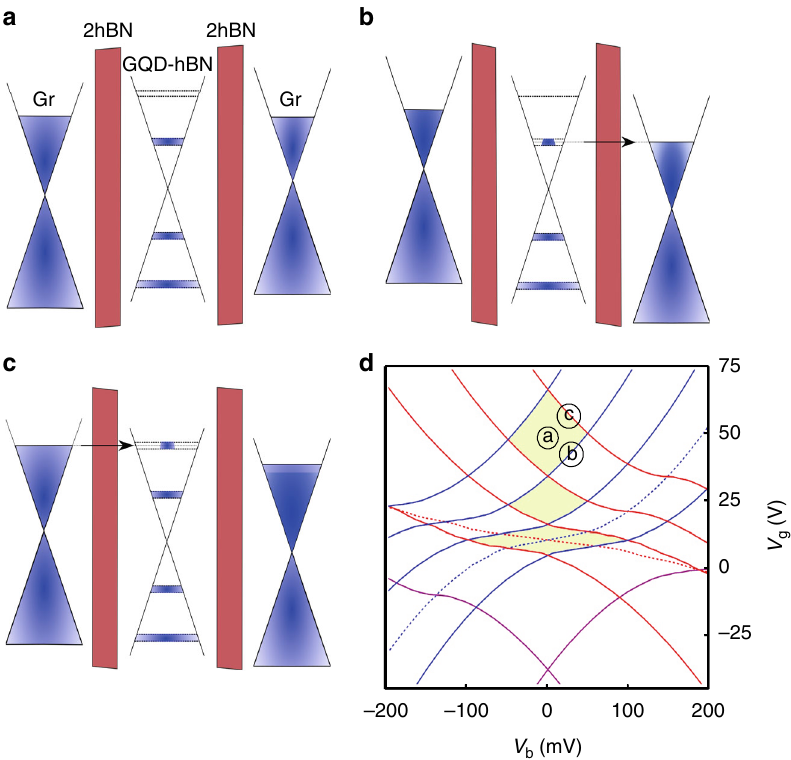
Fig. 6 Modelling of the single-electron charging effect. a – c Schematic representation of a single-electron charging effect. The corresponding electrostatic lines are denoted in d . d Modelling example of the alignment of the different energy levels in a device with 13 nm GQD (see Methods and Supplementary Notes 2 for the details of the modelling). Red (blue) dashed lines — Fermi level in top (bottom) graphene electrode aligning with the Dirac point. Purple lines — Fermi levels in the graphene contacts being aligned with the localised state located in the middle hBN layer with energy 140 meV below the Dirac point. The set of solid red (blue) lines correspond to single-electron energy levels in GQD aligning with the Fermi level in the top (bottom) electrode. Space between four of such lines forms a Coulomb blockade diamond. Note the distorted shape of the diamond when the Fermi level in the contacts passes through the Dirac